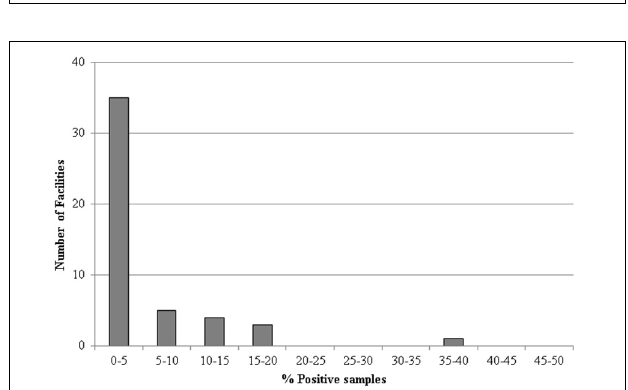
FIGURE 2 | Breakdown of the number of processing facilities positive for L. monocytogenes between March 2013 and March